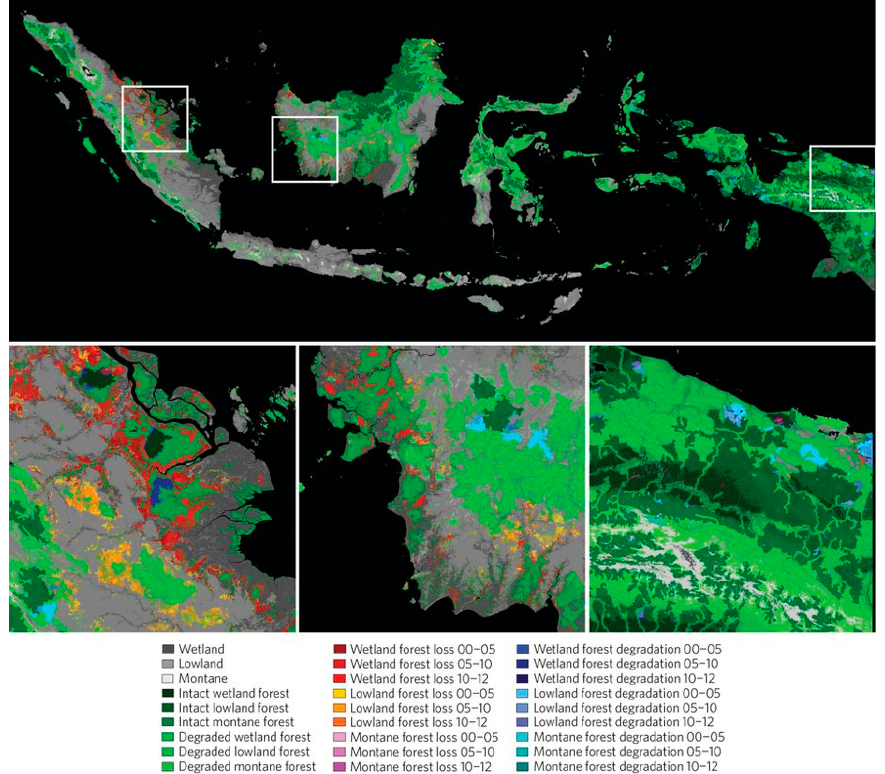
Figure 2. Deforestation in Riau (left below). The speed and coverage of deforestation are highest among other areas in Indonesia (Source: Margono et al. [60]).